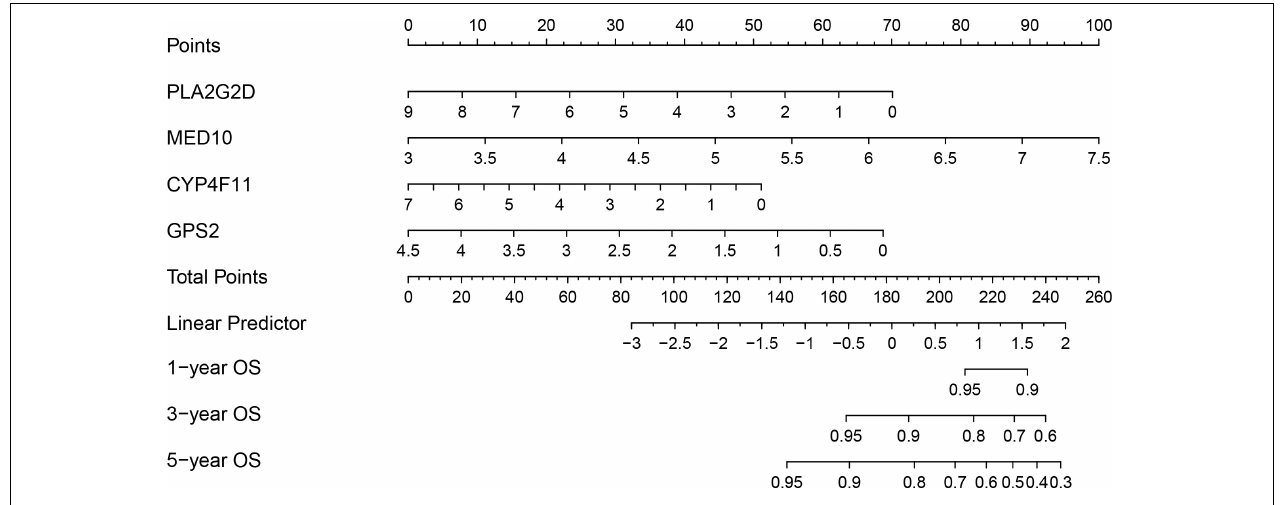
FIGURE 8 | Nomogram based on the prognosis-associated lipid metabolism-associated